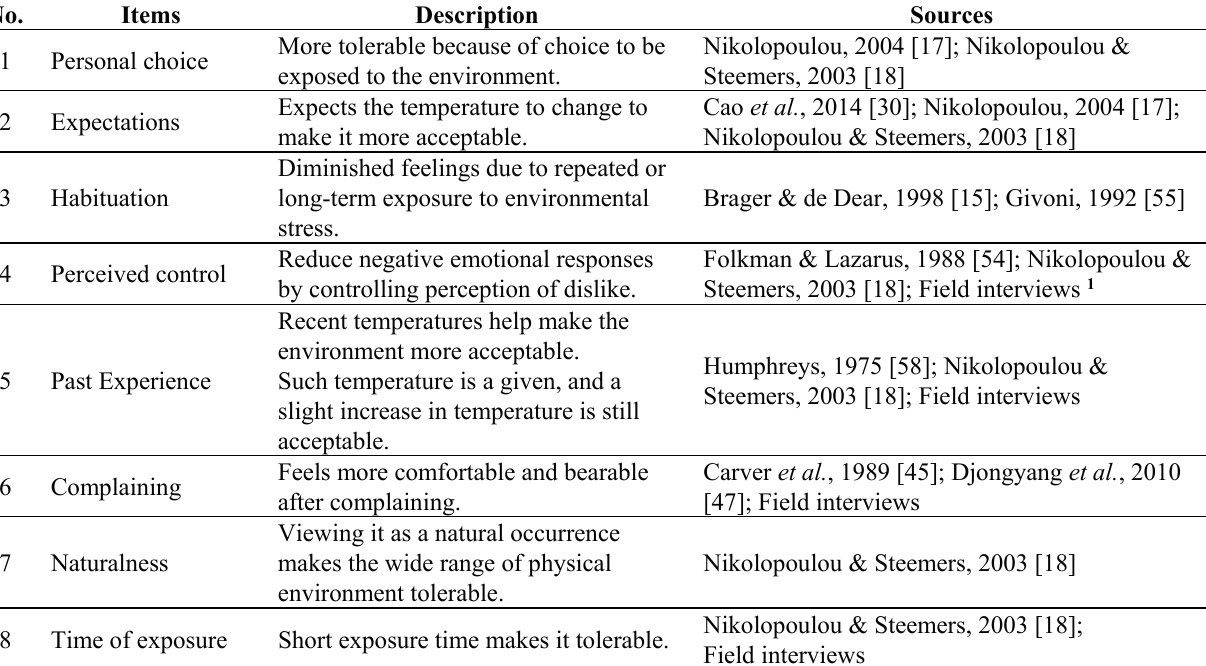
Table 1. Thermal adaptation strategies adopted by urban plaza users in hot and humid